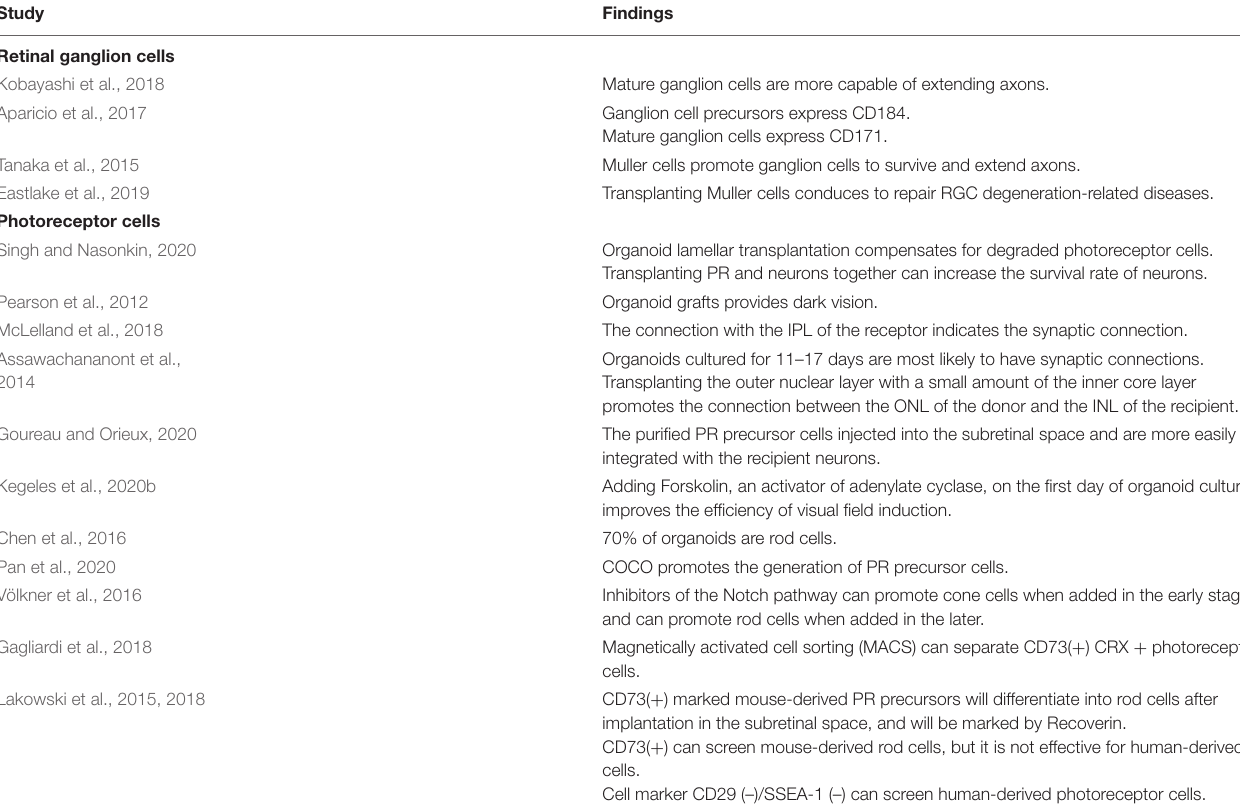
TABLE 2 | Summary of findings related to retinal organoid culture process and